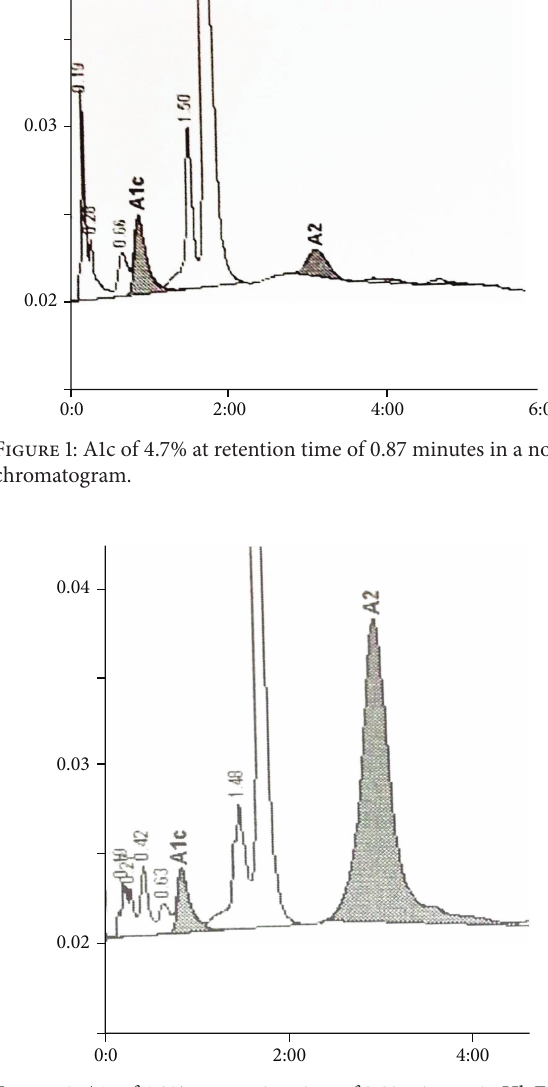
Figure 2: A1c of 4.8% at retention time of 0.83 minutes in Hb E